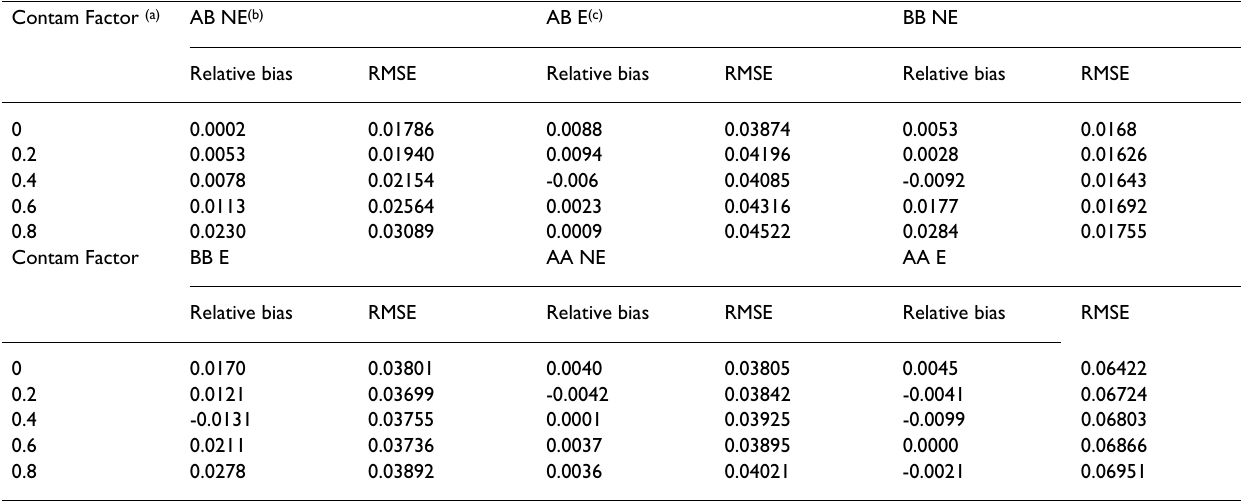
Table 2: Relative bias and RMSE of the disease risks predicted using the full model in the first scenario. Contam Factor